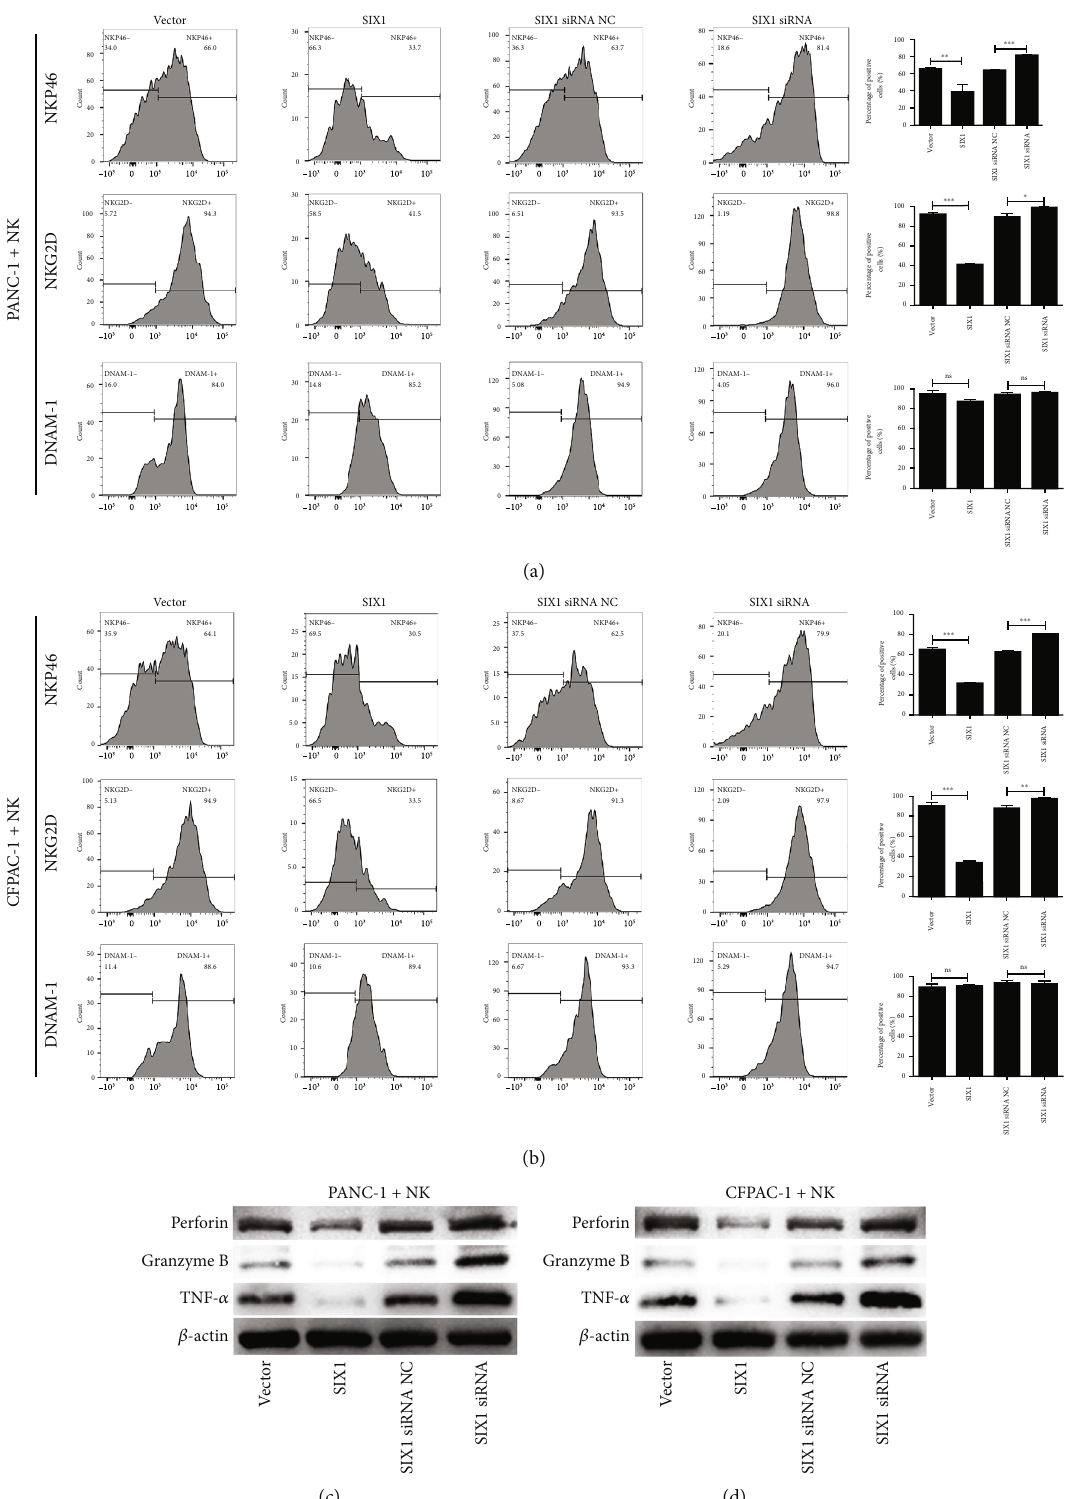
Figure 3: SIX1 overexpression in PC cells attenuates the function of NK cells. (a, b) The percentages of NKP46-, NKG2D-, and DNAM-1- positive NK cells cocultured with PANC-1 and CFPAC-1 cells. (c, d) Expression of perforin, granzyme B, and TNF- α in NK cells after coculture with PC cells according to western blotting; β -actin served as the internal control. The data are presented as the mean ± SD from three independent experiments. ∗ P ≤ 0 : 05 , ∗∗ P ≤ 0 : 01 , and ∗∗∗ P ≤ 0 : 001